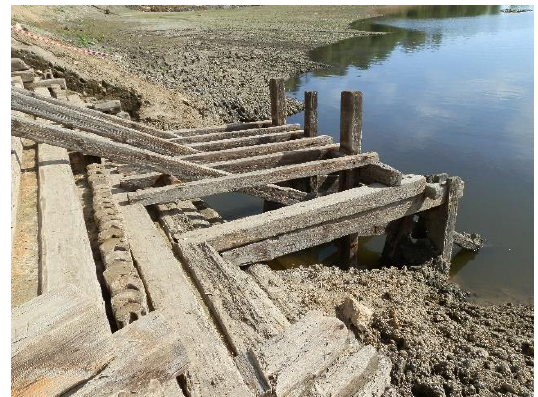
Figure 1. Tábor. Mediaeval wooden construction in the pond Jordán.